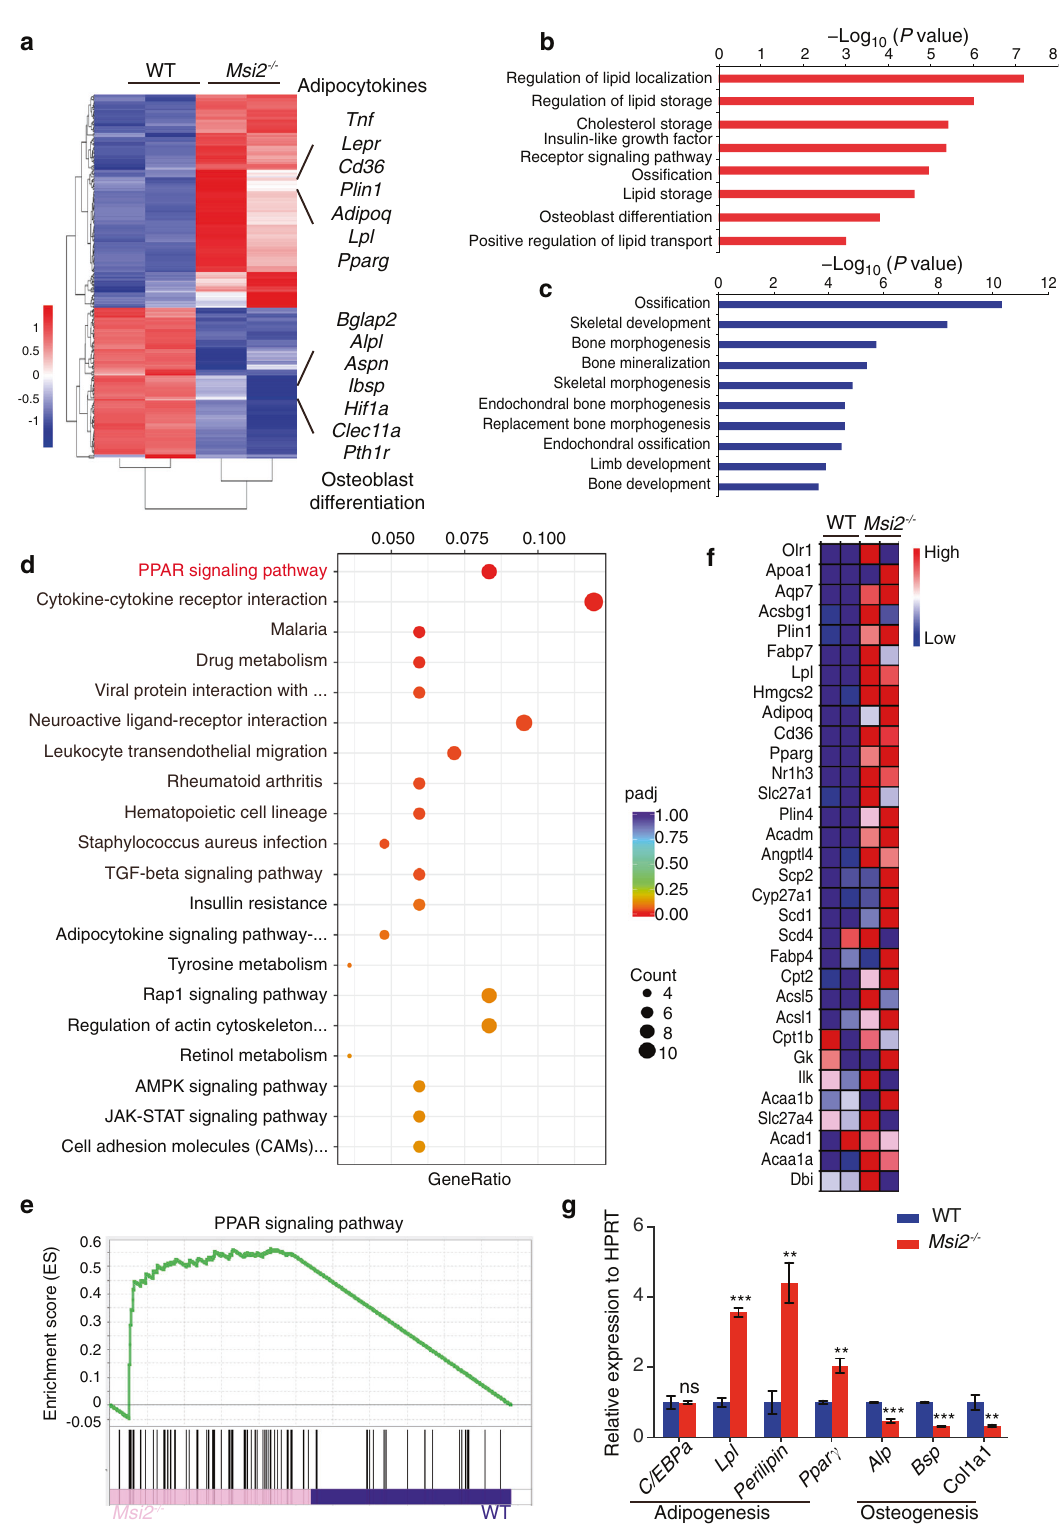
Fig. 5 MSI2 inhibits PPAR signaling in BMSCs. a Heatmap of RNA sequencing data between the WT and Msi2 − / − mouse BMSCs cultured in osteoblast differentiation medium for 7 days, n = 2 for each group. b Upregulated (red) GO analysis associated with signi fi cantly regulated genes ( P < 0.05) in the Msi2 knockout versus WT control groups. c Downregulated (blue) GO analysis associated with signi fi cantly regulated genes ( P < 0.05) in the Msi2 knockout versus WT control groups. d Upregulated (red) pathways associated with signi fi cantly regulated genes ( P < 0.05) in the Msi2 knockout versus WT control groups. e GSEA of the enrichment of all genes in RNA sequencing. f Heatmap of genes with upregulated expression in the PPAR signaling pathway obtained by GSEA. g qPCR results of adipogenesis-related gene ( Cebp α , Lpl, Perilipin, Ppar γ ) and osteogenesis-related gene ( Alp, Bsp, Col1 α 1 ) expression in the WT and Msi2 − / − mouse